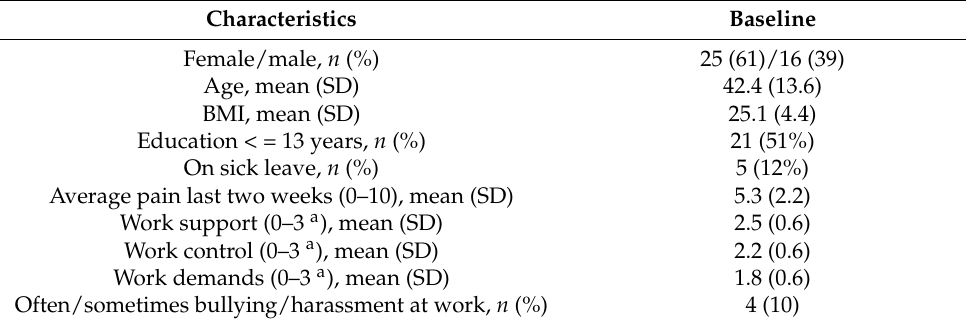
Table 1. Patient characteristics and psychosocial work conditions at